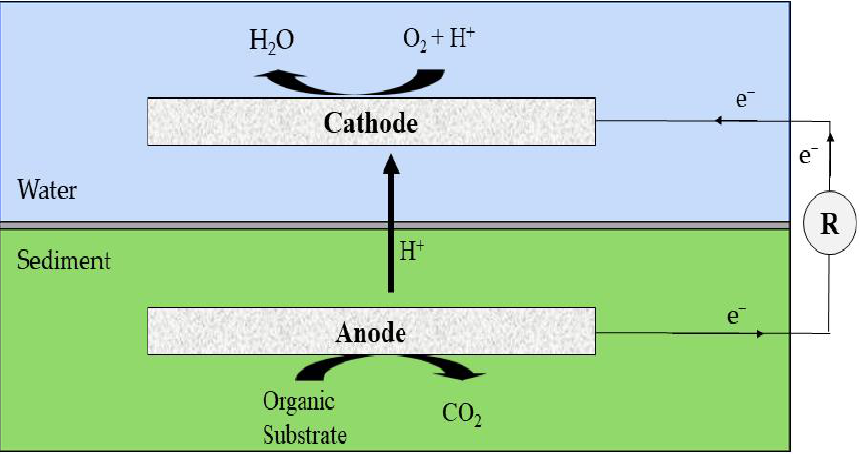
Figure 4. A typical integrated sediment MFC.